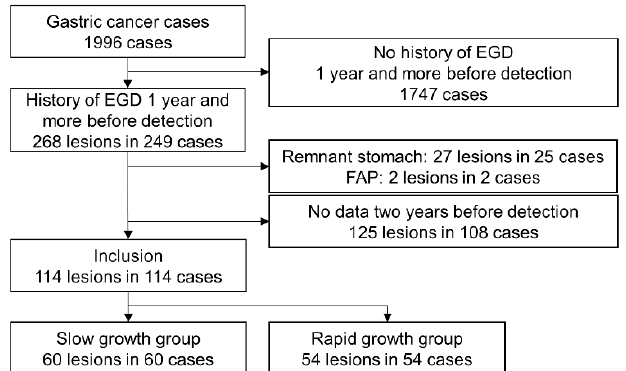
Figure 3. Patient flowchart. EGD, esophagogastroduodenoscopy; FAP, familial adenomatous